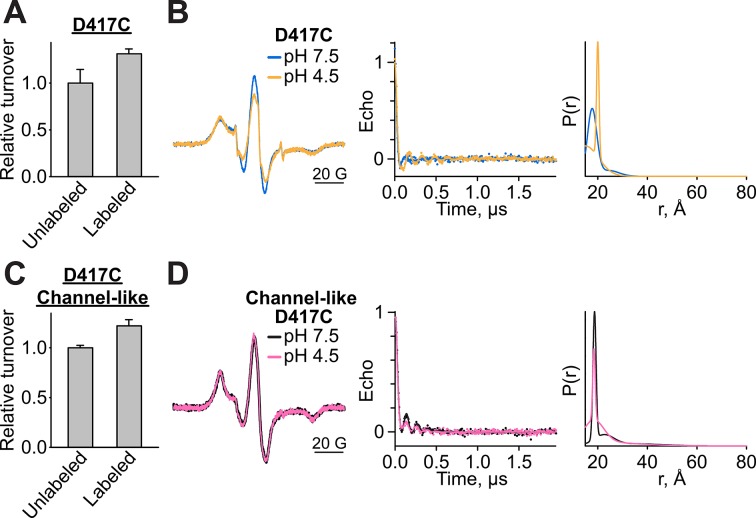
Functional-, CW-EPR, and DEER data analysis for spin-labeled D417C variants.(A) MTSSL-labeled D417C retains Cl--transport function, mean ± SEM for n=3–4. Cl- turnover of labeled samples was measured after the sample was exposed to pH 4.5 for 1 hr at room temperature before adjusting back to pH 7.5 for reconstitution. (B) CW-EPR (left), baseline-corrected DEER signals (middle) and fits corresponding to distance distributions (right) for D417C at pH 7.5 and 4.5. (C) MTSSL-labeled D417C/channel-like retains Cl--transport function, mean ± SEM for n=4. Cl- turnover of labeled samples was measured after the sample was exposed to the pH 4.5 condition for 1 hr at room temperature before adjusting back to pH 7.5 for reconstitution. (D) CW-EPR (left), baseline-corrected DEER signals (middle) and fits corresponding to distance distributions (right) for D417C/channel-like at pH 7.5 and 4.5.